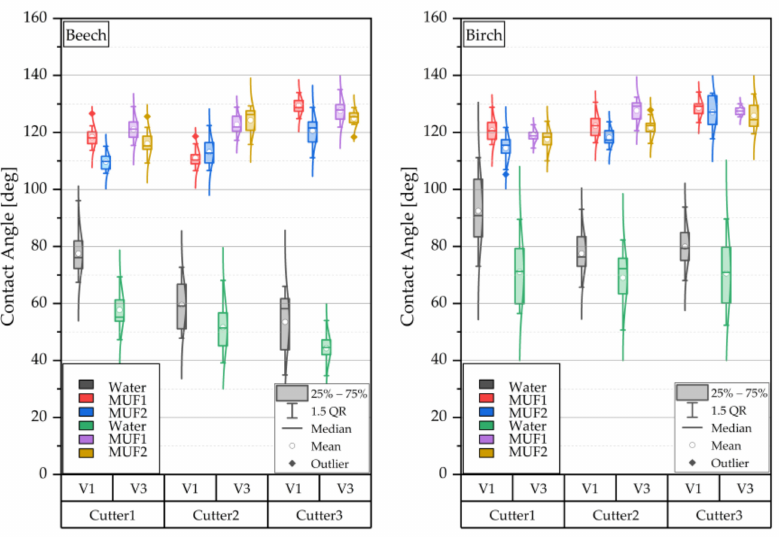
Figure 8. Effects on contact angle after water application and different viscous MUF-resins; Cu1 blunt, Cu2 medium sharp, and Cu3 sharp; F R 1 4 m min − 1 and F R 2 25 m min − 1